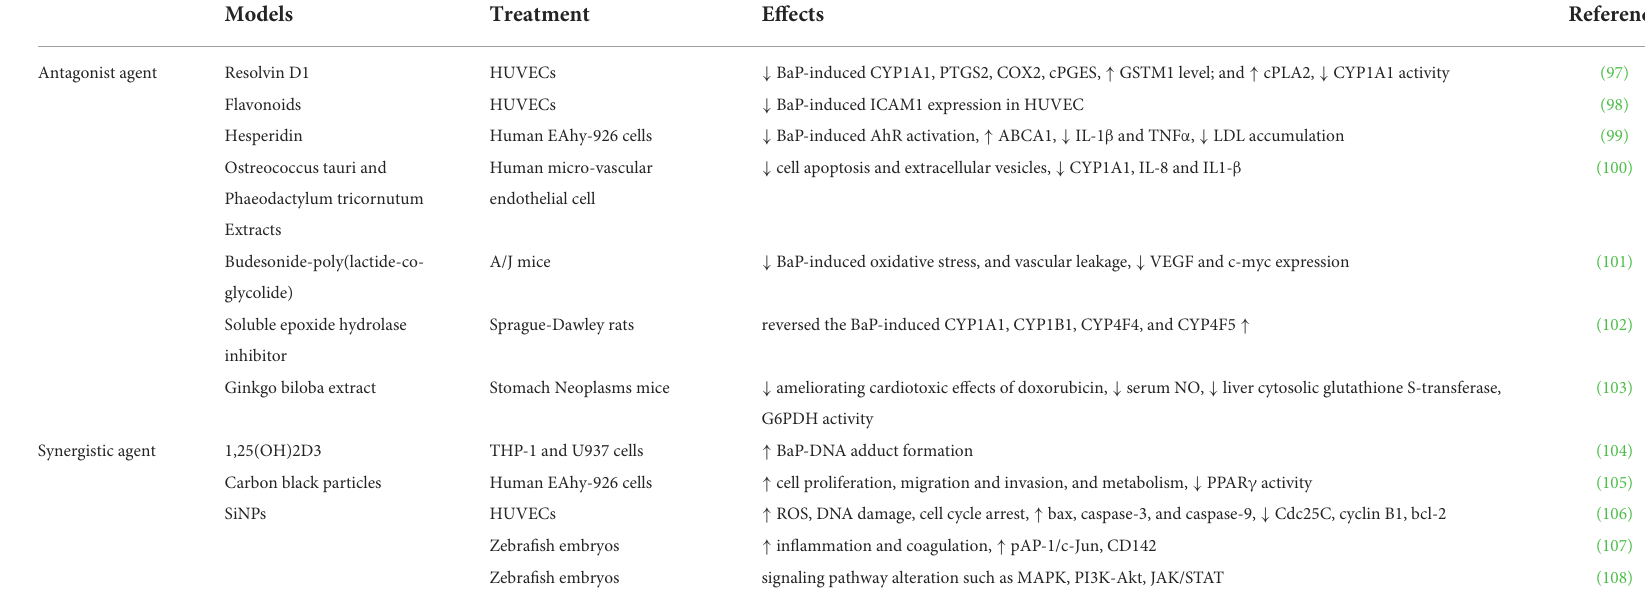
TABLE 3 Antagonist and synergistic agents of